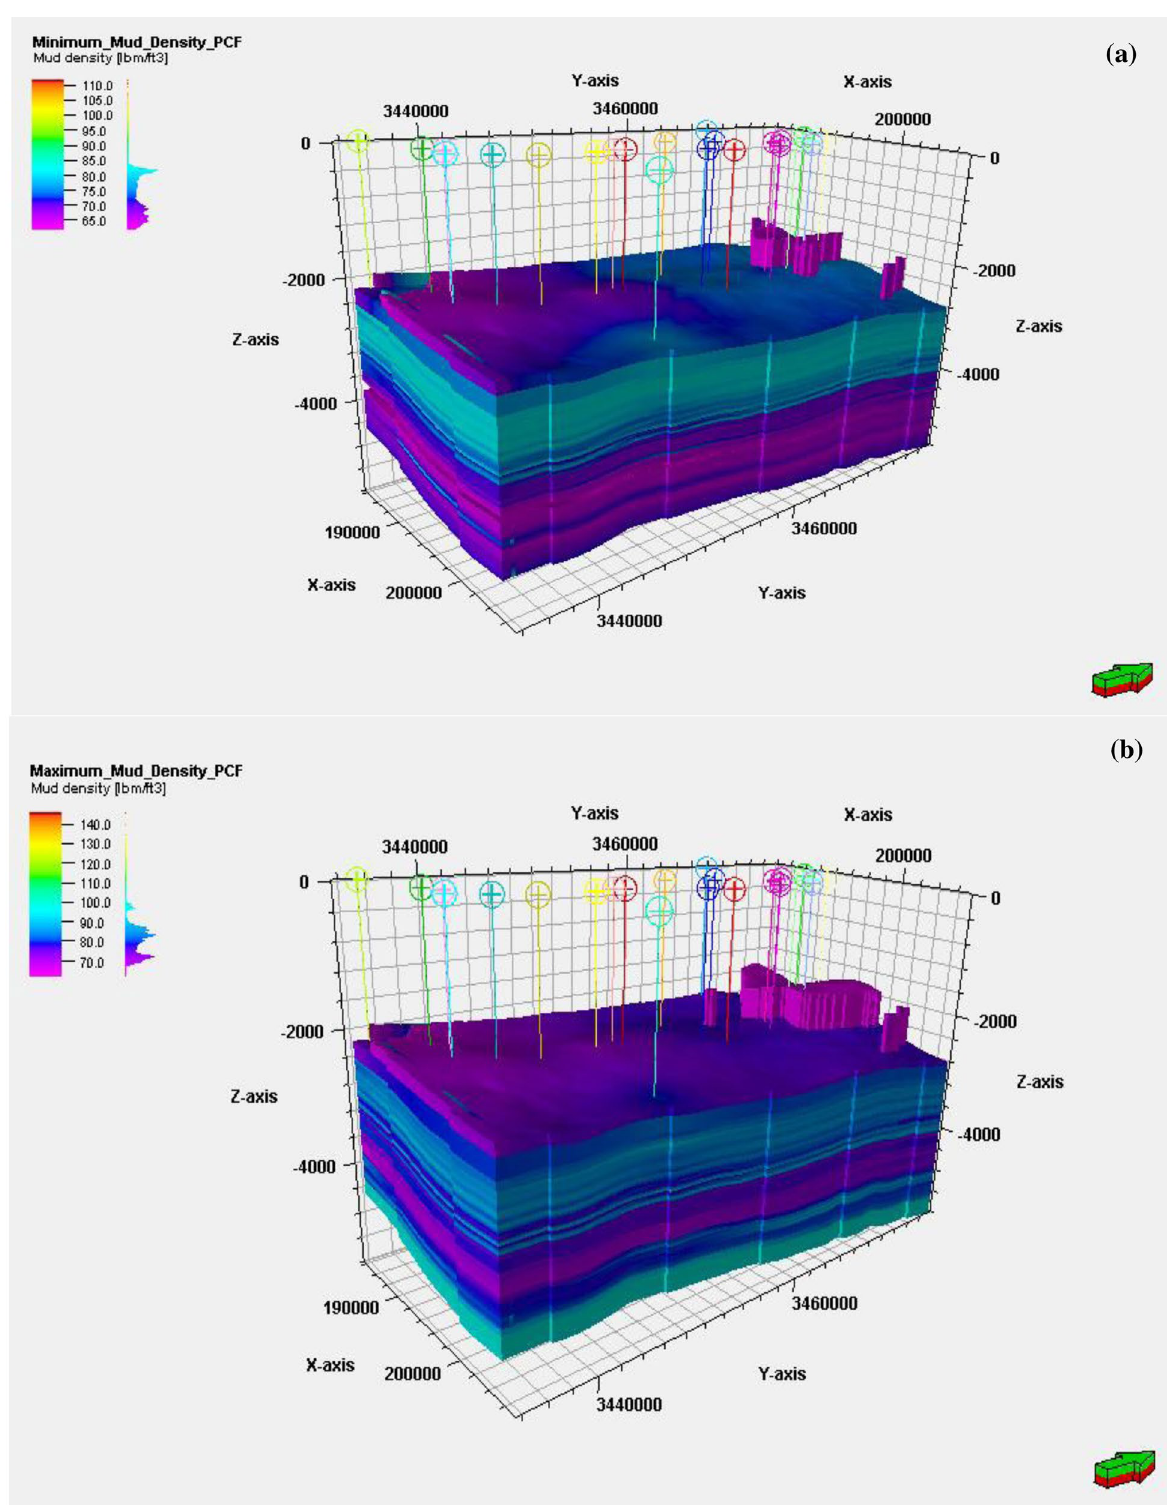
Fig. 20 Initial cube of a minimum mud weight based on pore pres- sure and adding 50 psi as a safety margin, considering the minimum weight of 62.4 PCF, b maximum mud weight based on the cube of